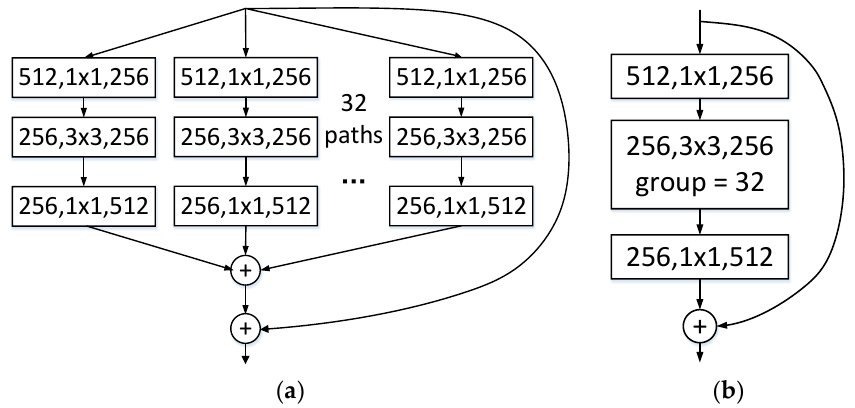
Figure 4. Equivalent building blocks of EDSRSP-1 × 1. ( a ) Aggregated residual transformations. ( b ) A block equivalent to (a), implemented as grouped convolutions.